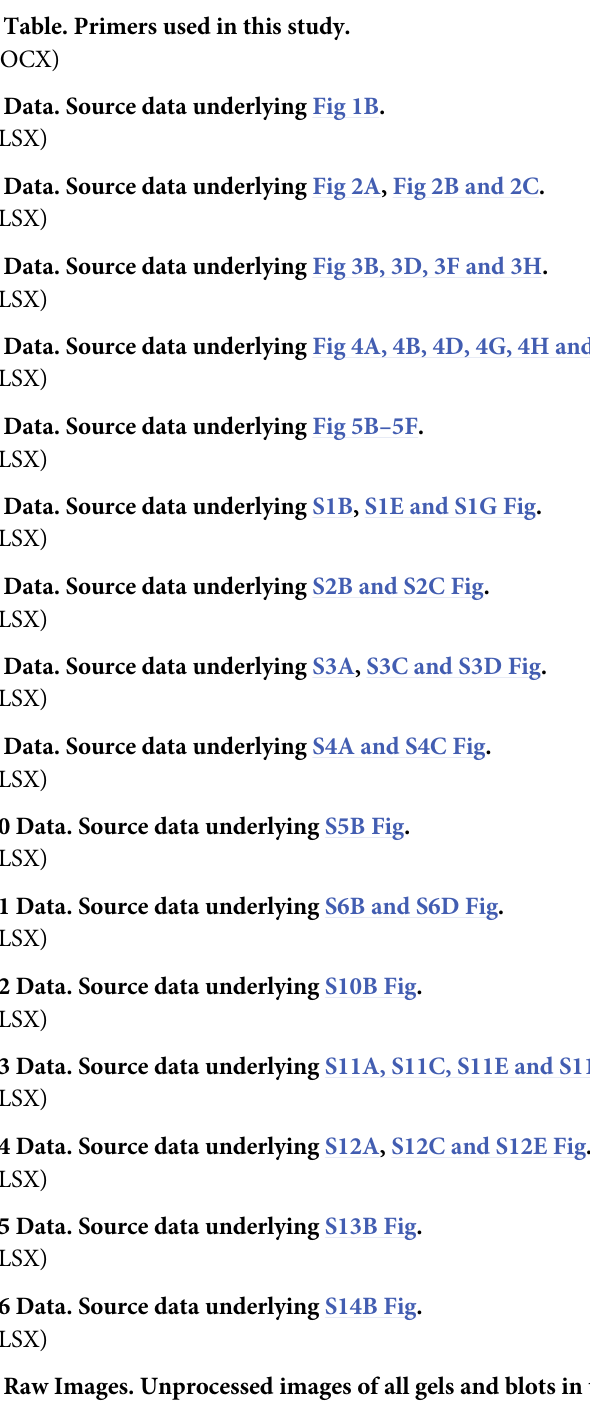
S1 Table. Primers used in this